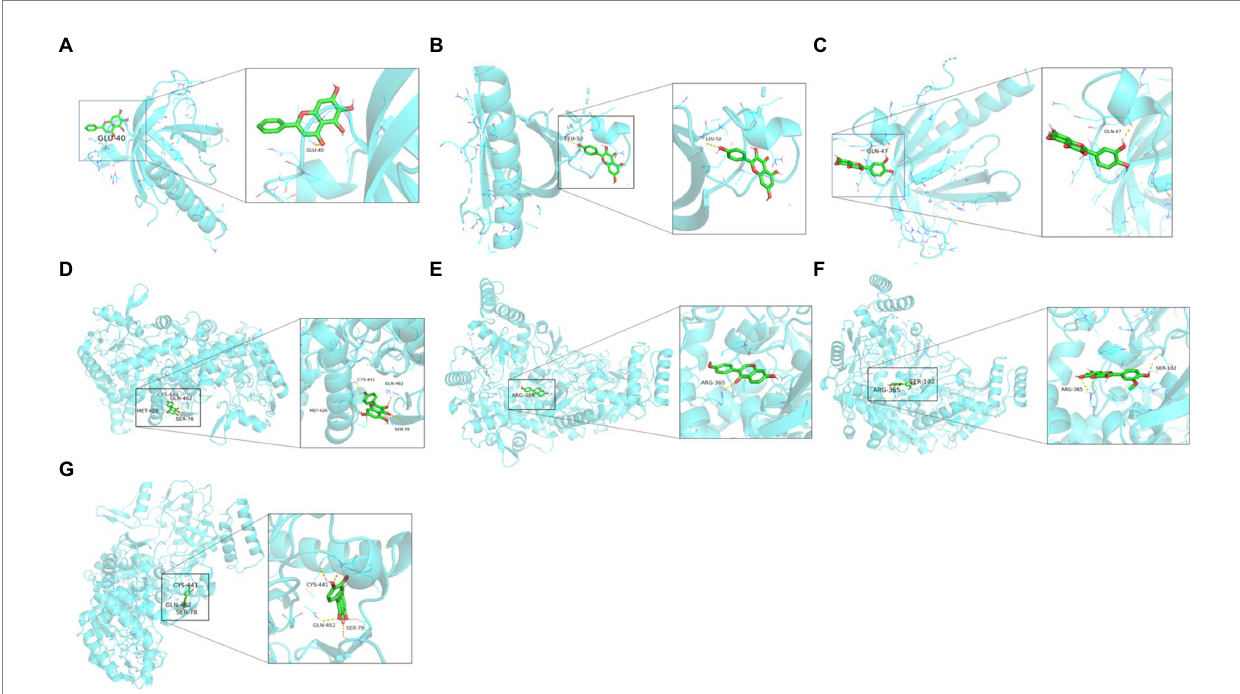
FIGURE 9 Molecular docking analytic data. (A) AKT1 docks with baicalein. (B) AKT1 docks with kaempferol. (C) AKT1 docks with quercetin. (D) NOS3 docks with kaempferol. (E) NOS3 docks with formononetin. (F) NOS3 docks with isorhamnetin. (G) NOS3 docks with quercetin. The blue molecular structure shows the target site, while the green molecular structure is the active